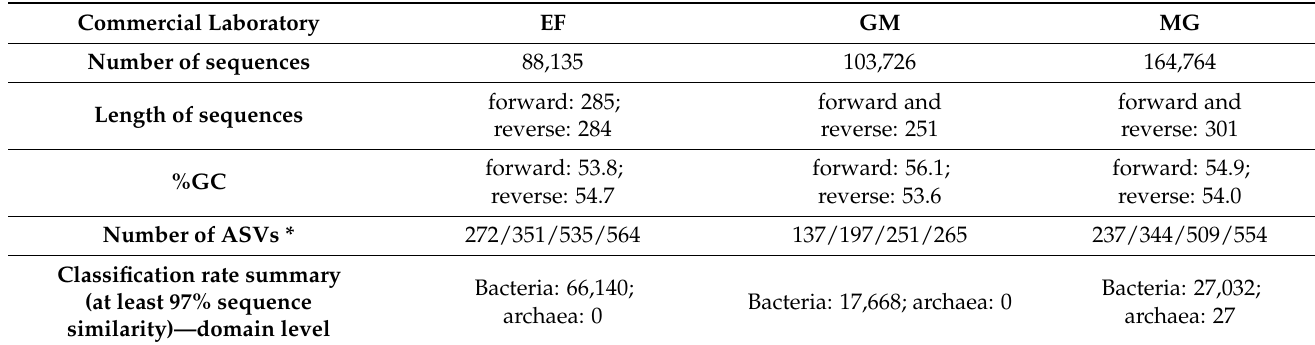
Table 4. Comparison of HTS results from three commercial